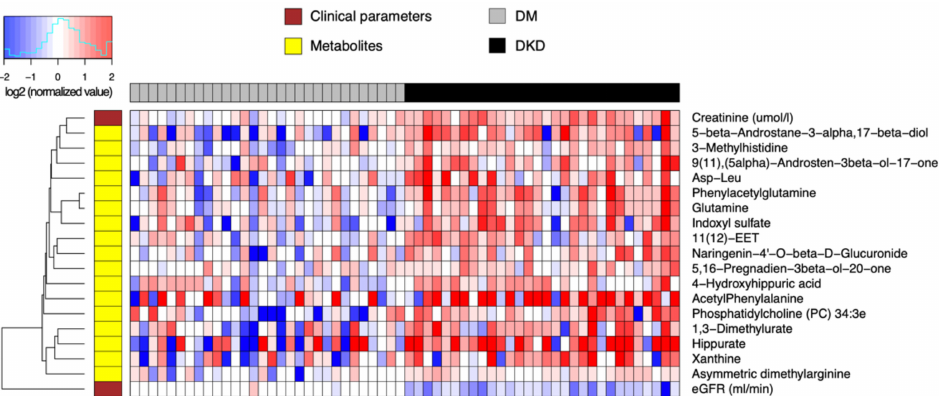
Figure 2. Heatmap of relative abundance values of endogenous compounds (log-transformed, base 2) differentially abundant between 30 DKD patients and 30 DM-N. Data were normalized by the median of the 30 DM-N samples in each